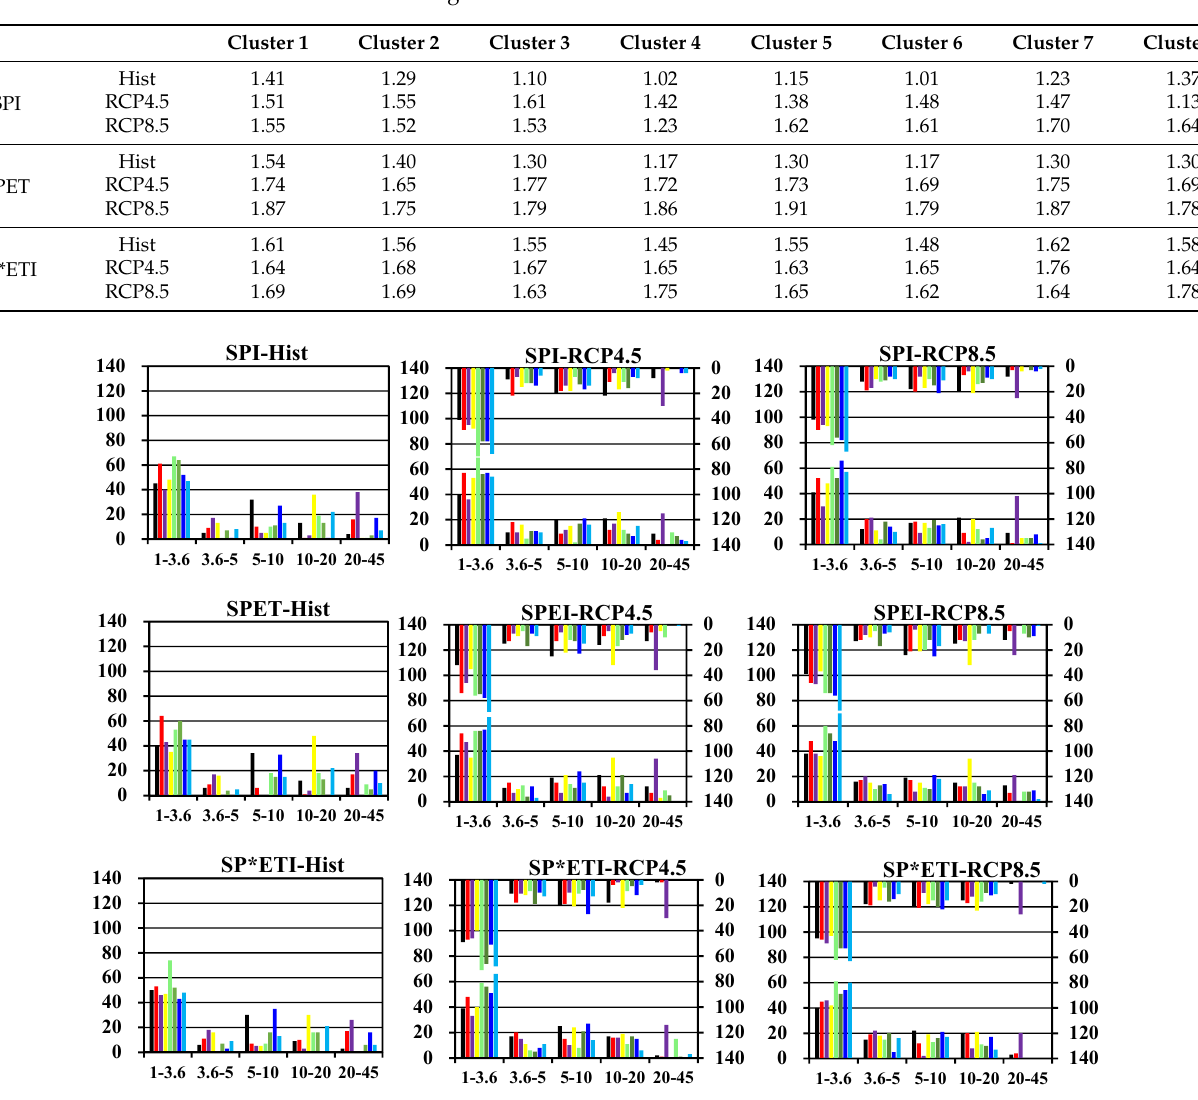
Table 5. Drought hazard indices for the different clusters.